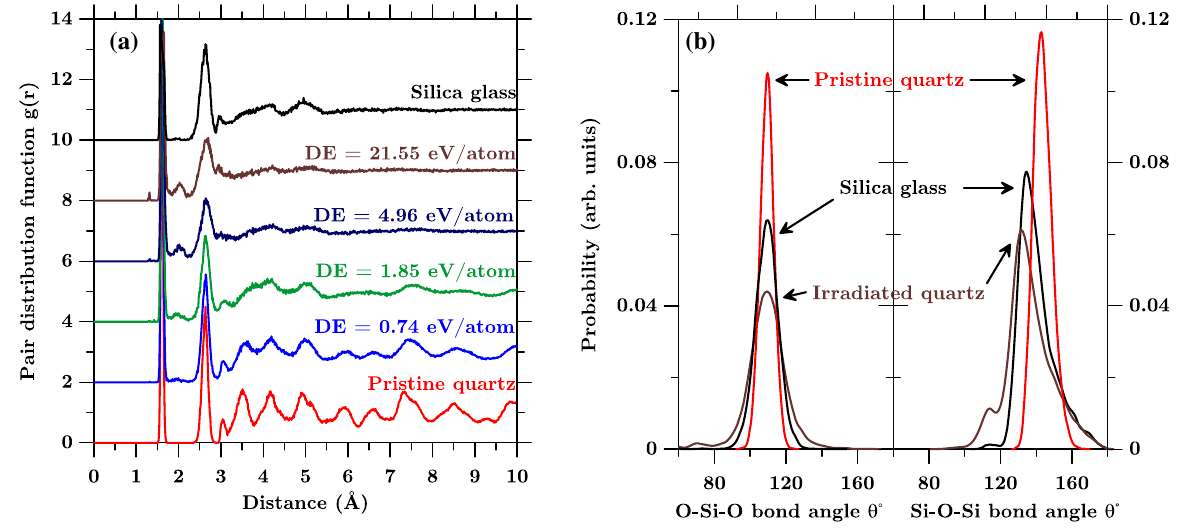
FIG. 2. Comparison between irradiated quartz and glassy silica. (a) Pair distribution functions of pristine α -quartz, irradiated quartz with increasing dosages of DE, and glassy silica. (b) Intratetrahedral (O – Si – O) and intertetrahedral (Si – O – Si) bond angle distributions in pristine α -quartz, glassy silica, and fully irradiated